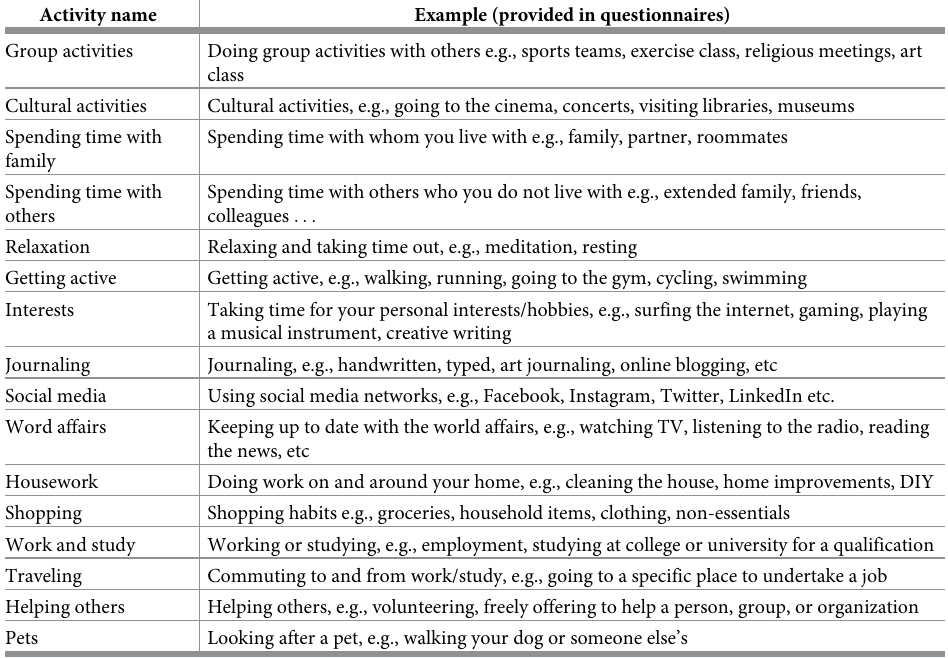
Table 1. Activity type and